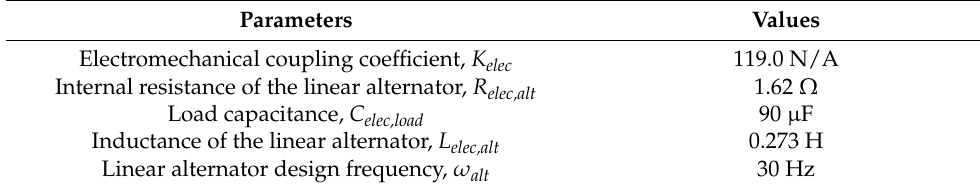
Table 3. Design parameters of the linear alternator.